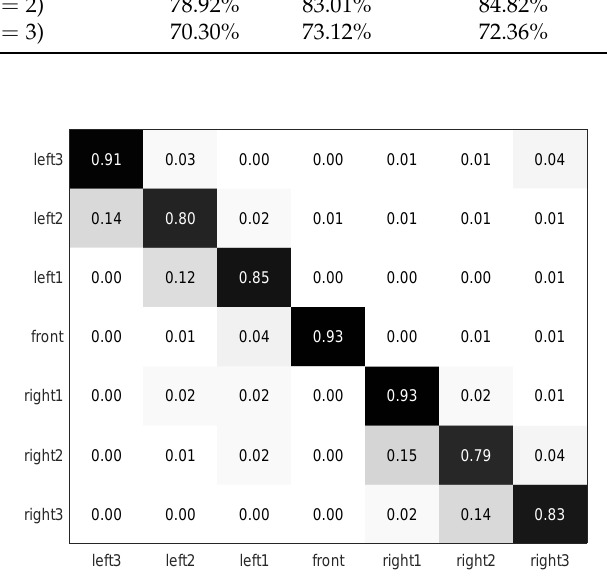
Figure 7. Classification confusion matrix filled with normalized accuracies in the case of 7 navigation choices. Diagonal elements denote correct classification; while off-diagonals denote